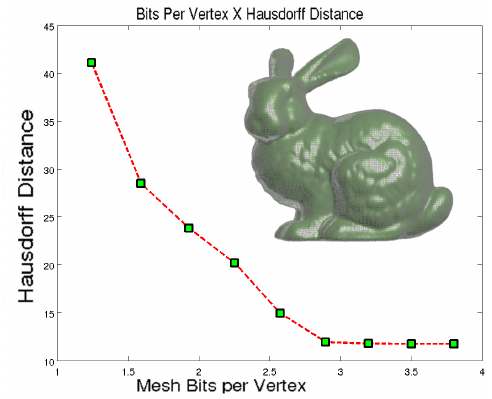
Figure 15: Hausdorff distance depending on the compression rate (BPV) to the Bunny model